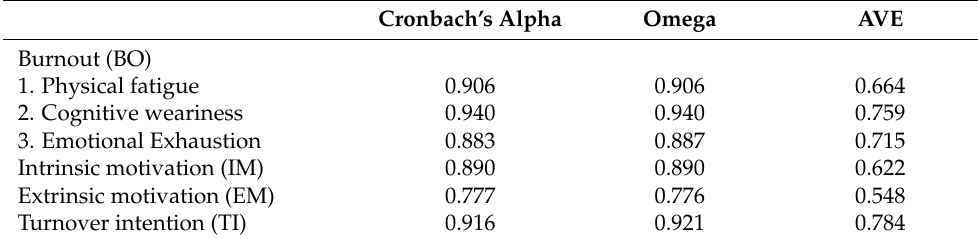
Table 3. Internal consistency and extracted